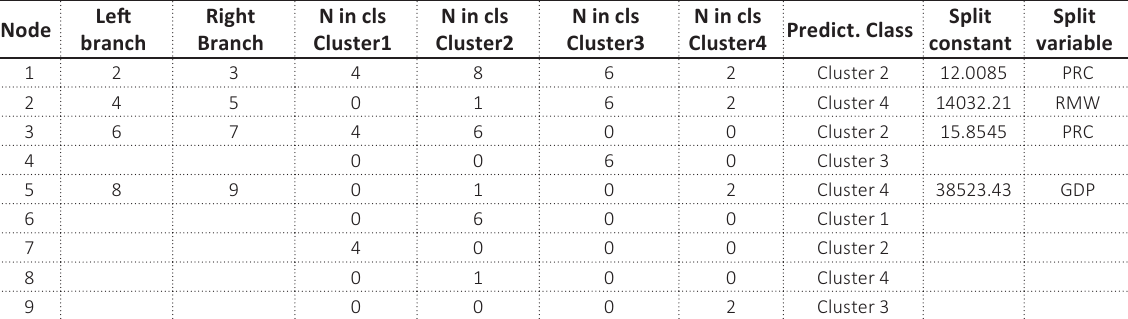
Figure 2. Classification tree according to the scenarios of combating crimes against human life and health Table 4. Classification tree structure according to the scenarios of combating crimes against human life and health